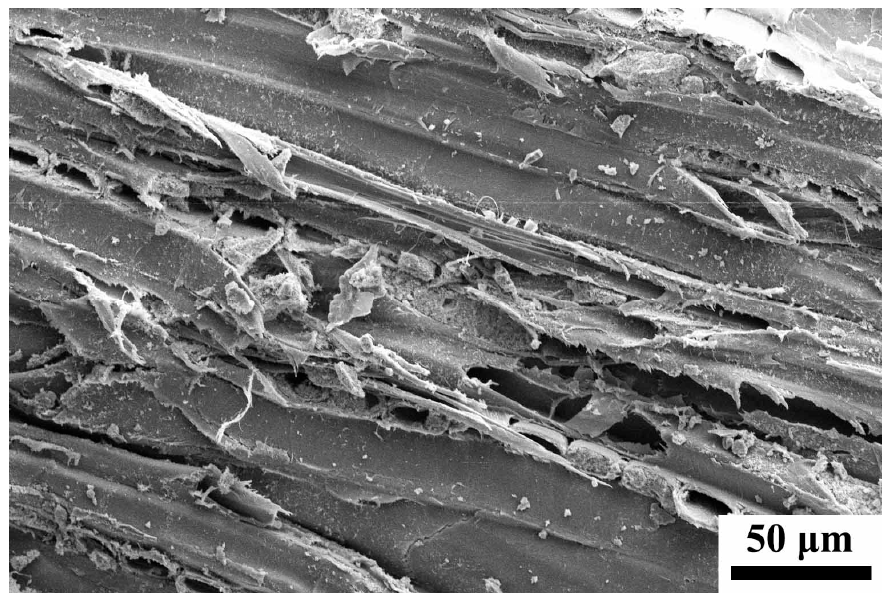
Figure 4. SEM micrograph of the fracture surface of the wood surface bonded by the MOC-7 adhesive.